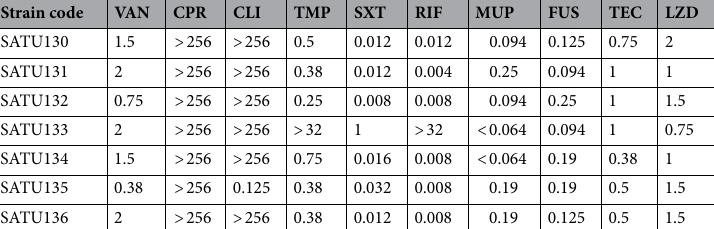
Table 2. Minimal inhibitory concentrations of antibiotics against the MRSA isolates. VAN vancomycin, CPR cefpirome, CLI clindamycin, TMP trimethoprim, SXT trimethoprim-sulfamethoxazole, RIF rifampicin, MUP mupirocin, FUS fusidic acid, TEC teicoplanin, LZD